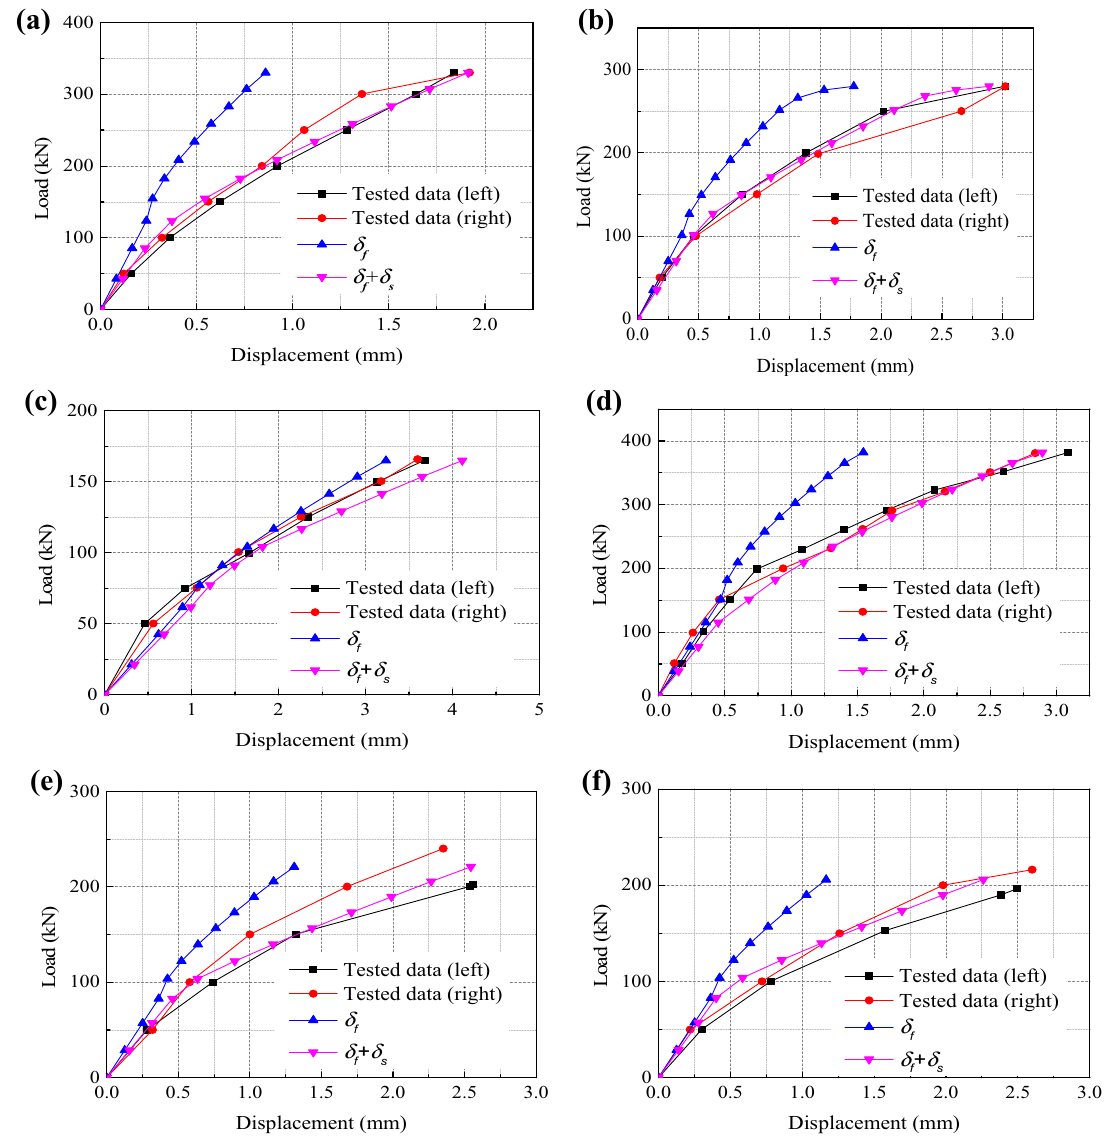
Fig. 10 Measured and predicted load–displacement curves of RECC columns. a Specimen E1, b Specimen E2, c Specimen E3, d Specimen E4, e Specimen E5 and f Specimen